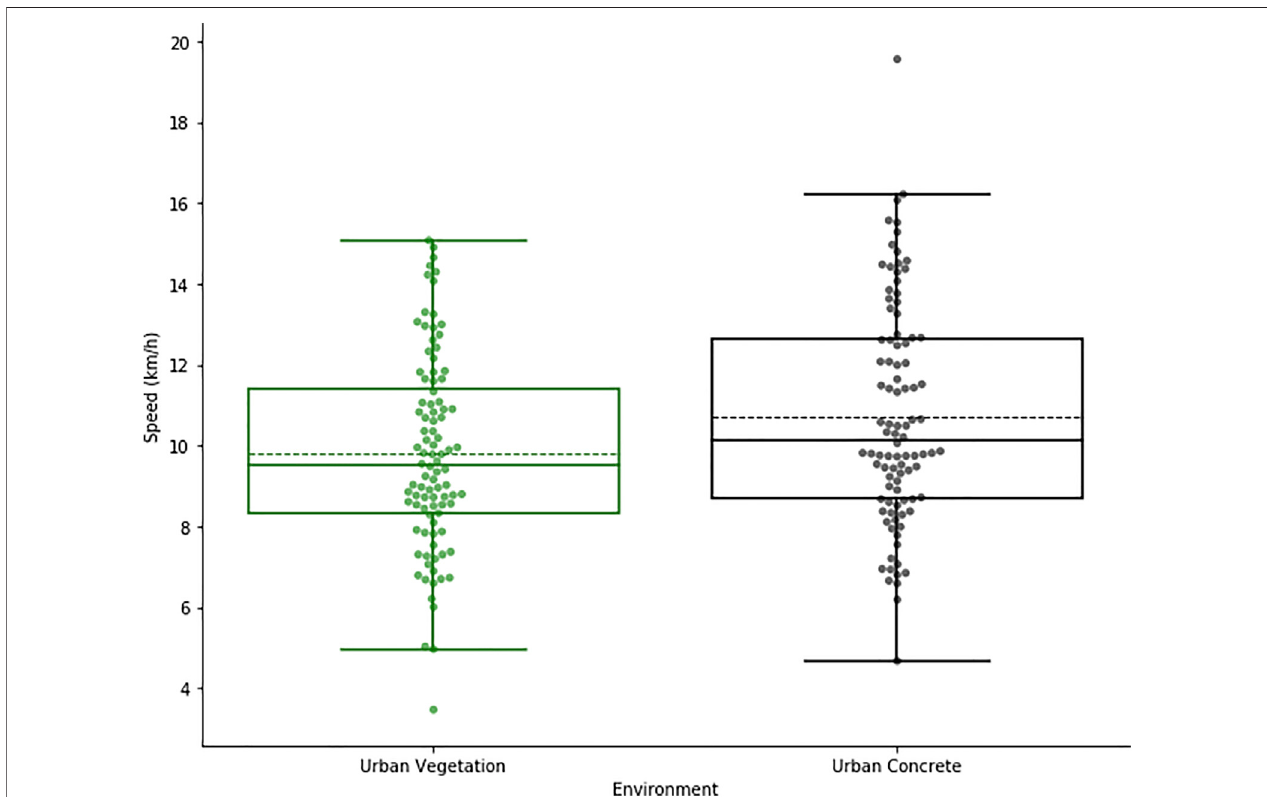
FIGURE7| Barcharts illustrating theimpactofEnvironment(Concrete vs .Vegetation)on thespeedofspontaneous walking inthetwourban virtualenvironments.